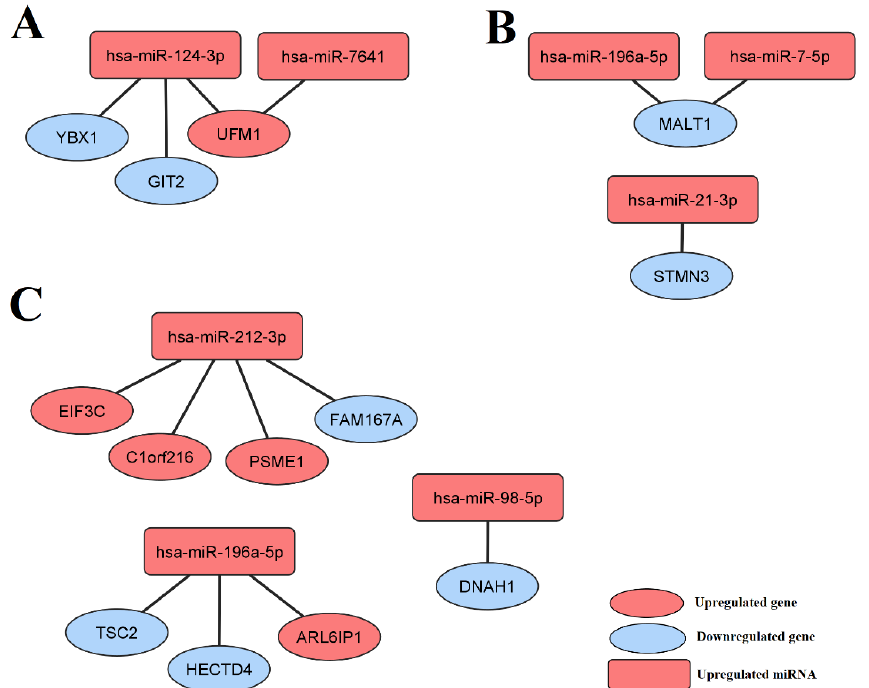
Figure 3. The regulatory network containing miRNAs selected in the current study and genes selected from a previous study [47] regarding ( A ) LEAD vs. AAA comparison, ( B ) AAA vs. CVD comparison, and ( C ) LEAD vs. CVD comparison. AAA—abdominal aortic aneurysm, CVD—chronic venous disease, LEAD—lower extremity artery